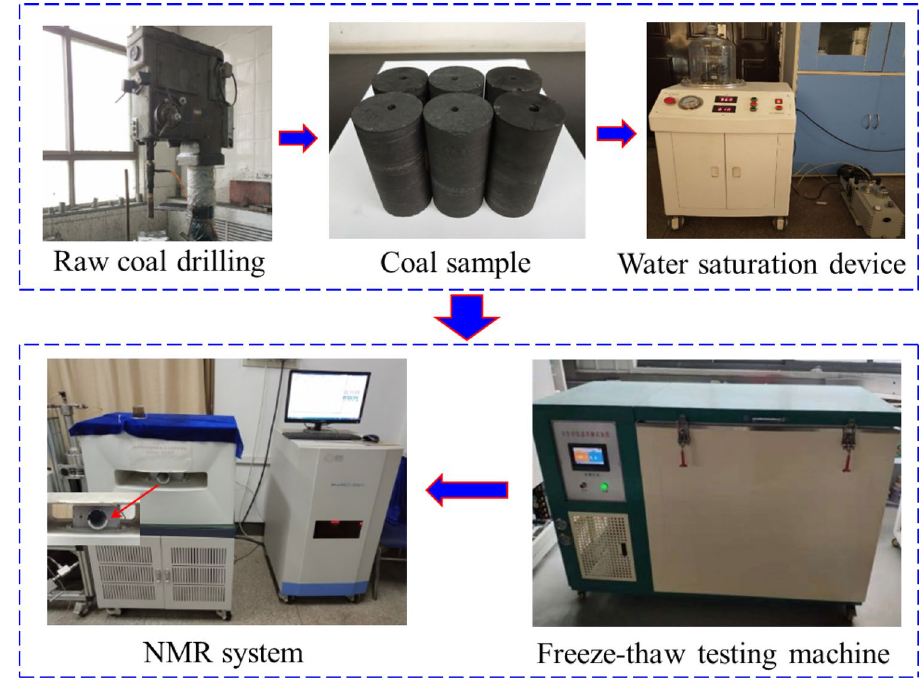
Figure 1. System diagram of NMR